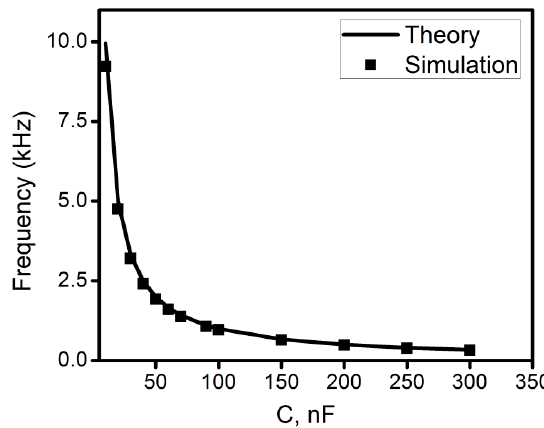
Figure 9. Theoretical and simulation results, varying values of C